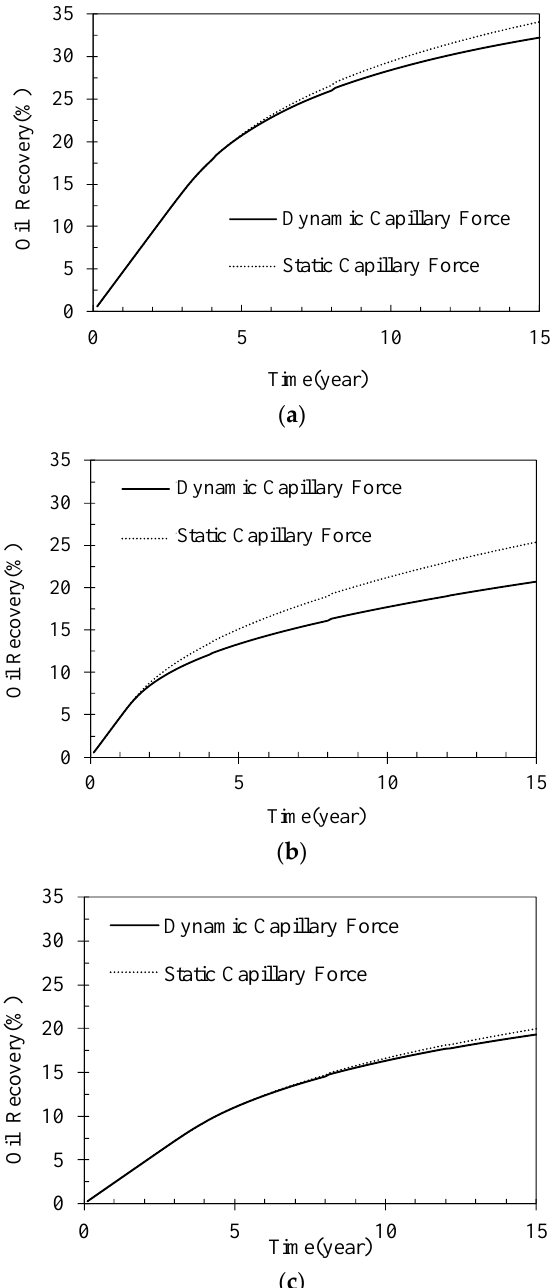
Figure 8. Oil recovery curves of the three different reservoir permeability distributions. ( a ) Oil recovery curves of the homogeneous reservoir. ( b ) Oil recovery curves of horizontal heterogeneous reservoir. ( c ) Oil recovery curves of vertical heterogeneous reservoir.